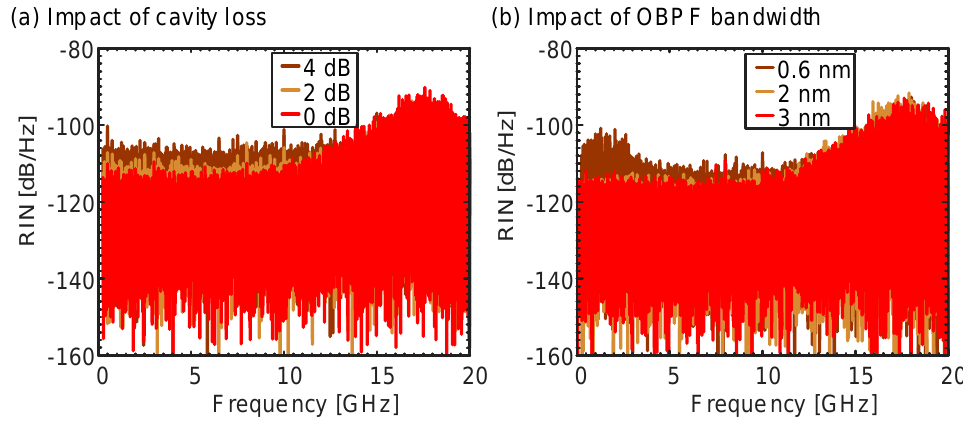
Figure 11. RIN characterization of the RSOA-FCL: ( a ) The RIN increases when introducing additional loss in the cavity; ( b ) The impact of the optical bandpass filter (OBPF) bandwidth on the RIN is shown.